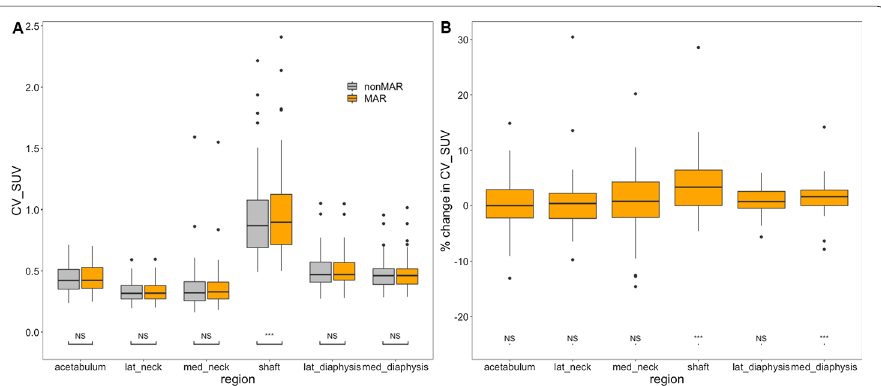
Fig. 9 Effect of MAR on variation coefficient of the SUV in regions around the prostheses. Panel A is a boxplot describing the variation coefficient of the SUV according to whether or not MAR was applied for PET attenuation correction. Panel B is a boxplot describing the percentual change of the variation coefficient induced by MAR. Boxes and whiskers are as in Fig. 7. Statistical significance of the difference with use of MAR is indicated in panel A ; in panel B it is indicated whether the percentual increase in the variation coefficient differs significantly from 0 (NS denotes not significant, * p < 0.05, ** p < 0.01, *** p < 0.001. lat_neck lateral